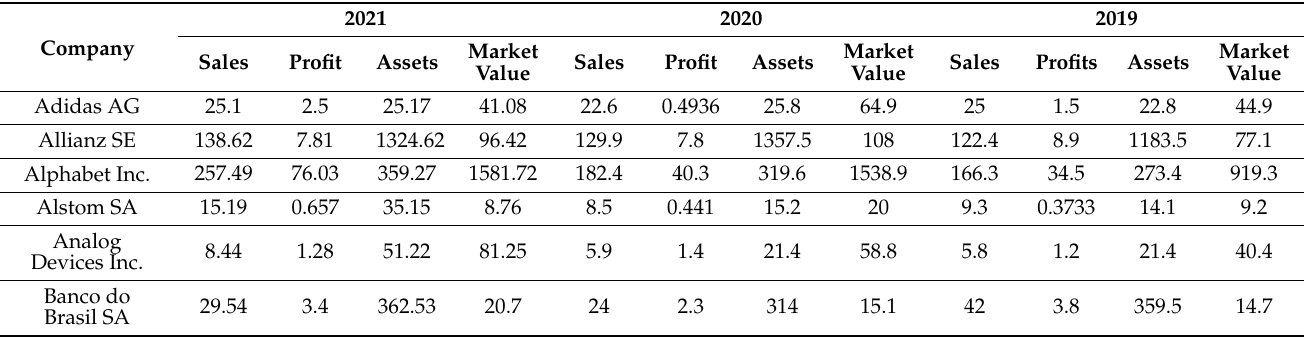
Table A2. Financial performance of companies in the sample in 2020–2021,